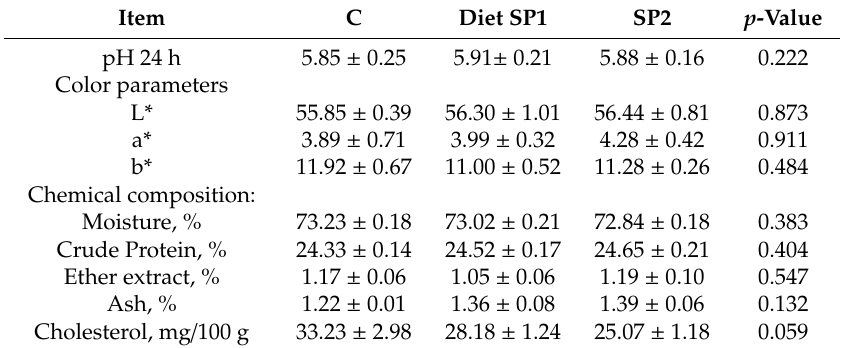
Table 4. Physical and chemical parameters of Longissimus lumborum muscle of rabbits fed the control diet (C) and diet supplemented with 3 g / kg (SP1) and 6 g / kg (SP2) of brown seaweed and plant